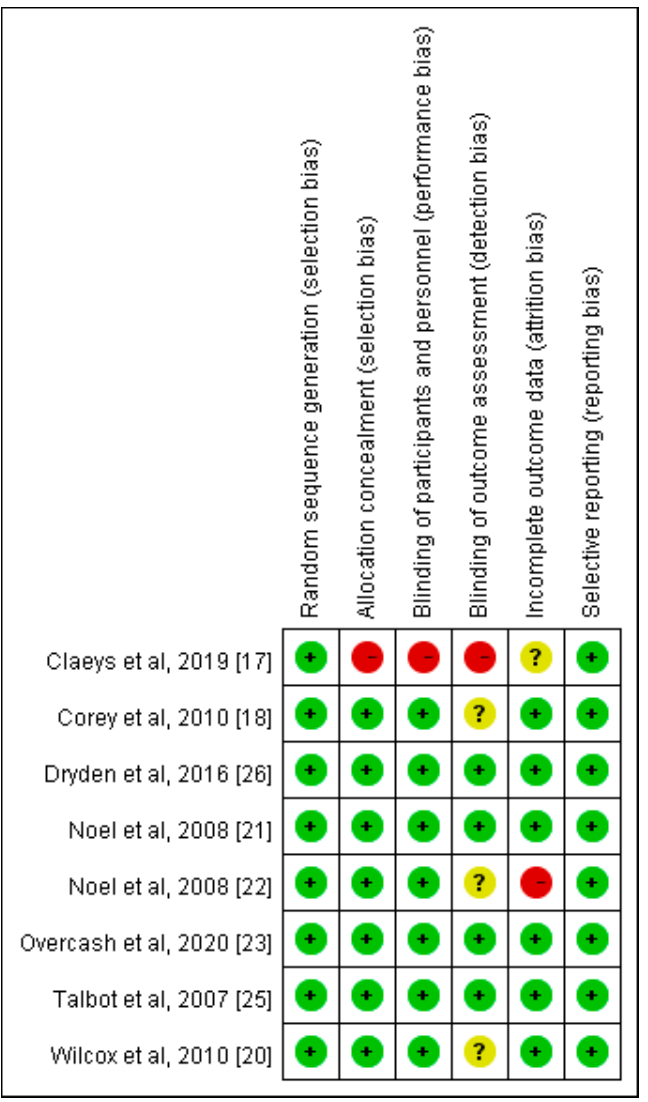
Figure 2. Summary of risk of bias.